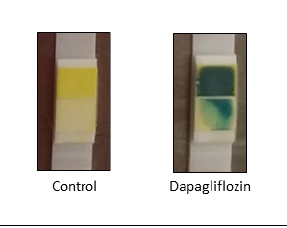
Figure 3. Representative image of glucose levels in urine after 11 days of Sodium glucose cotransporter 2 (SGLT2) inhibition. Dapagliflozin was administered at a dose of 40 mg/kg. Yellow = 0 mmol/L glucose and blue = 278 mmol/L glucose.